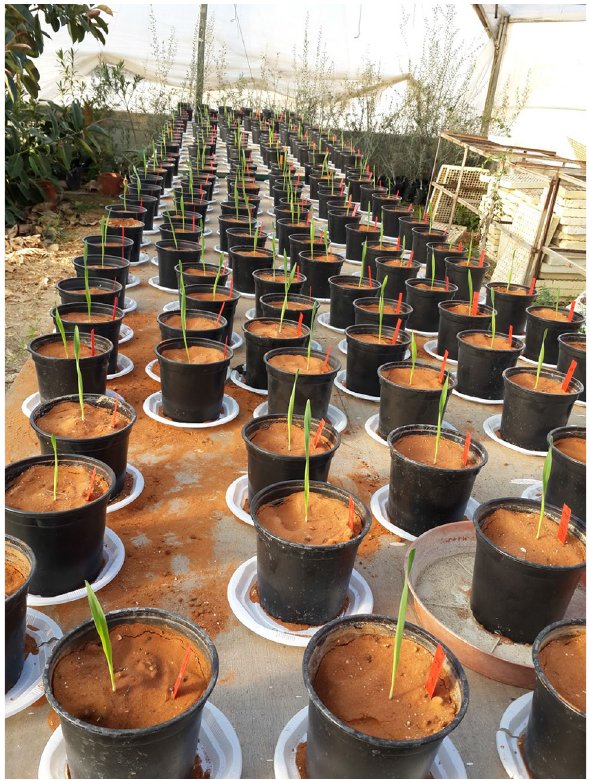
1. Picture of barley plants at one leave germination.